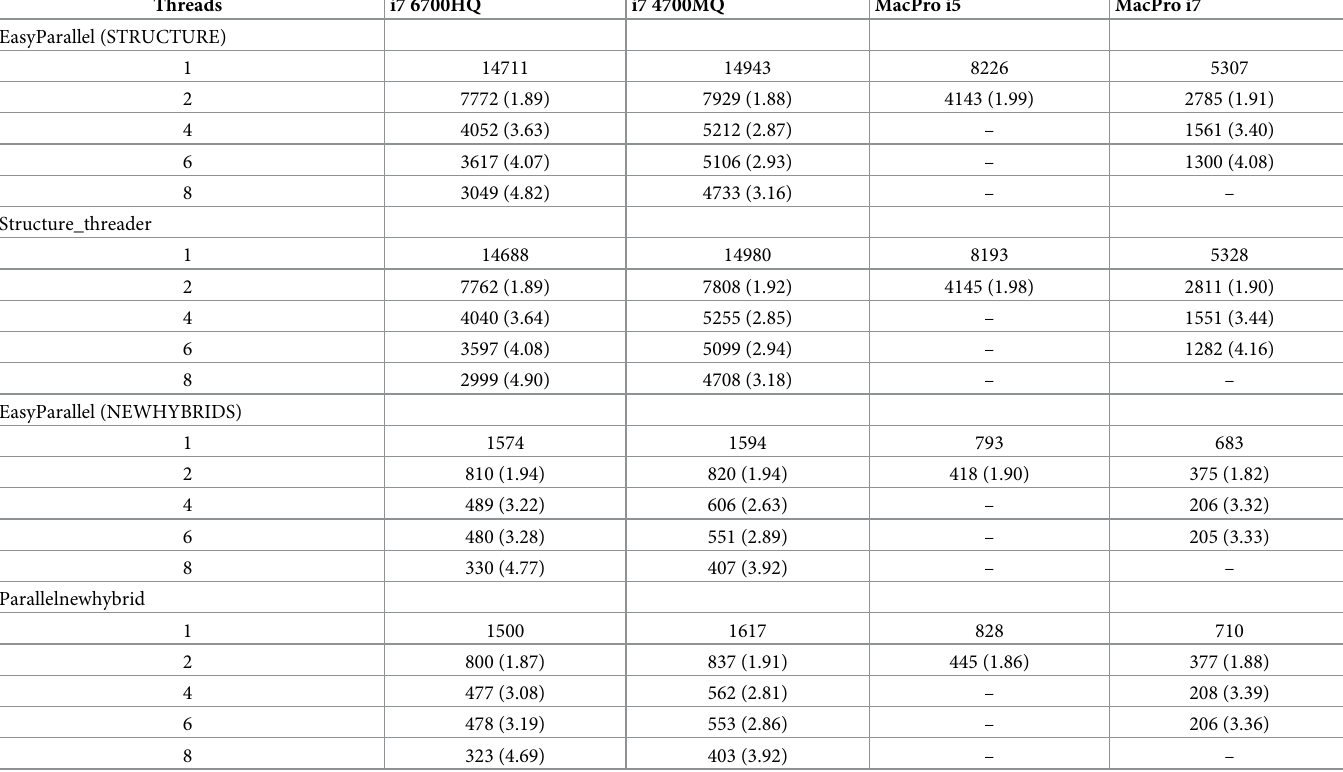
Table 1. Computational time (s) required to complete STRUCTURE and NEWHYBRIDS analyses in series compared to in parallel using EasyParallel, Structure_ threader, and Parallelnewhybrid. The speed gain (in parentheses) was calculated by dividing the execution time on a single thread (sequential run) by the execution time obtained from different number of threads. The analyses were repeated using different operating system and CPU architectures: i7 4700MQ – Lenovo Y510, Windows 10, 2.4 GHz Intel Core i7- 4700MQ with 8 GB RAM and 4 physical cores (8 logical threads); i7 6700HQ – Lenovo Y700, Windows 10, 2.6 GHz Intel Core i7-6700HQ with